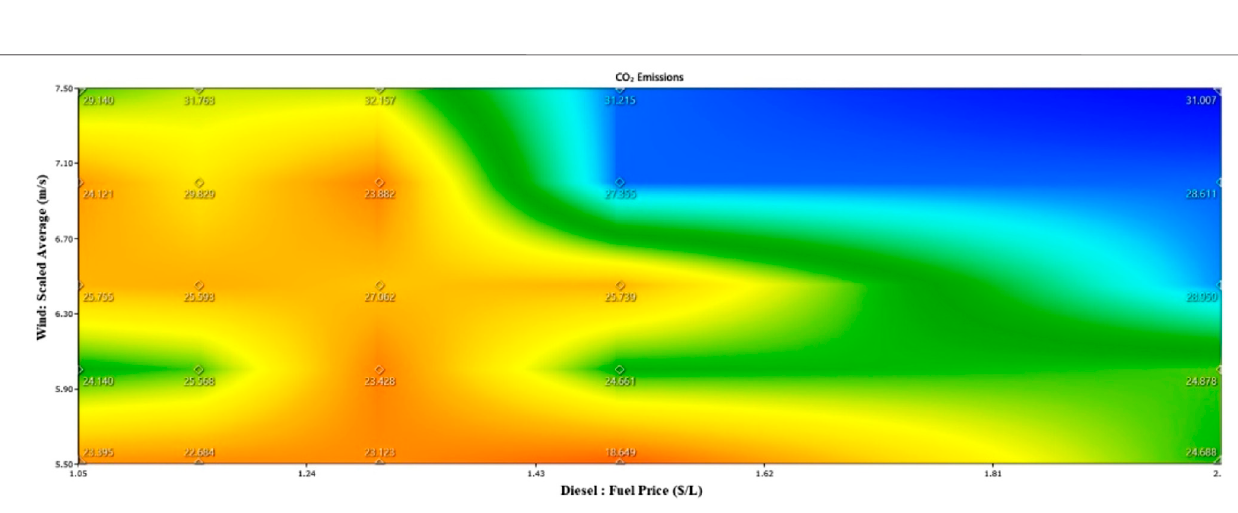
Frontiers in Energy Research |